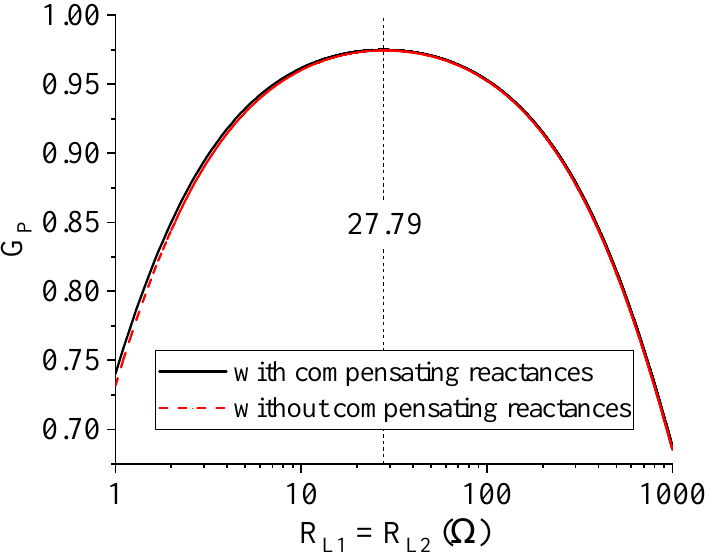
Figure 5. Case 1: efficiency calculated for Case 1 by varying the resistive part of the loads R L1 = R L2 = R L while all the other parameters are set to the optimal values.